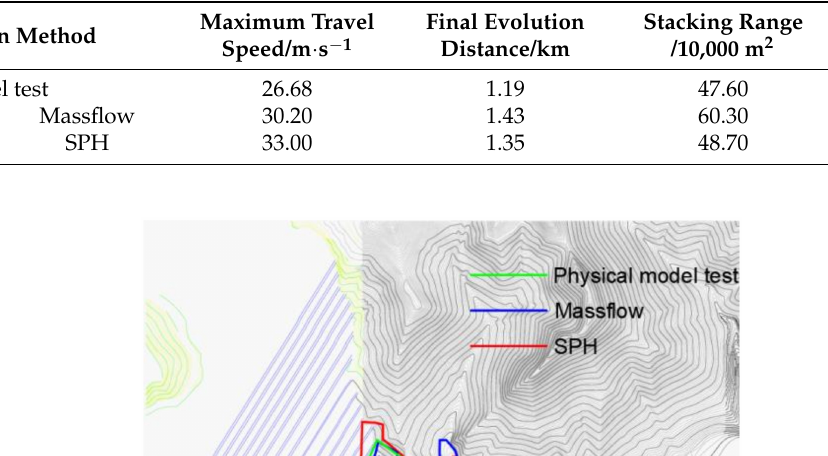
Table 4. Comparison of numerical simulation results and physical model test results.